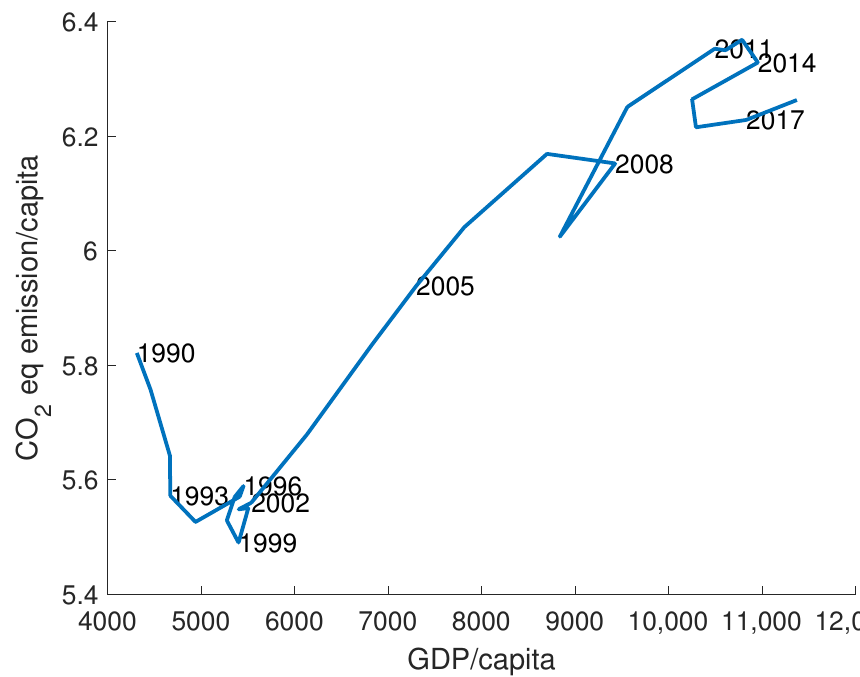
Figure 13. Kuznets function of the